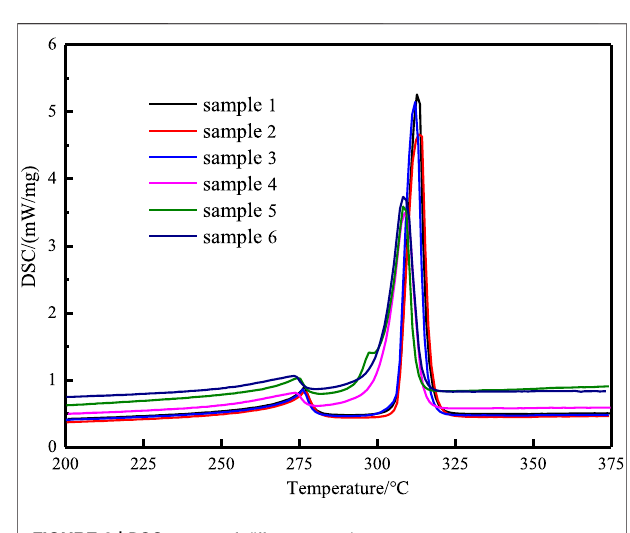
FIGURE 9 | DSC curves of different